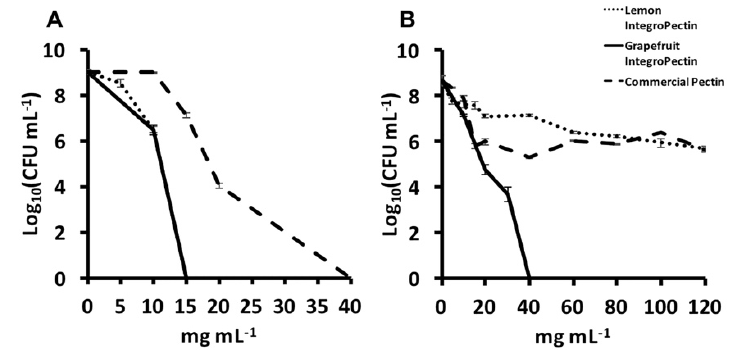
Figure 4. Minimal bactericidal concentration of either lemon or grapefruit IntegroPectin, as well as the commercial citrus pectin against ( A ) Pseudomonas aeruginosa and ( B ) Staphylococcus aureus strains.